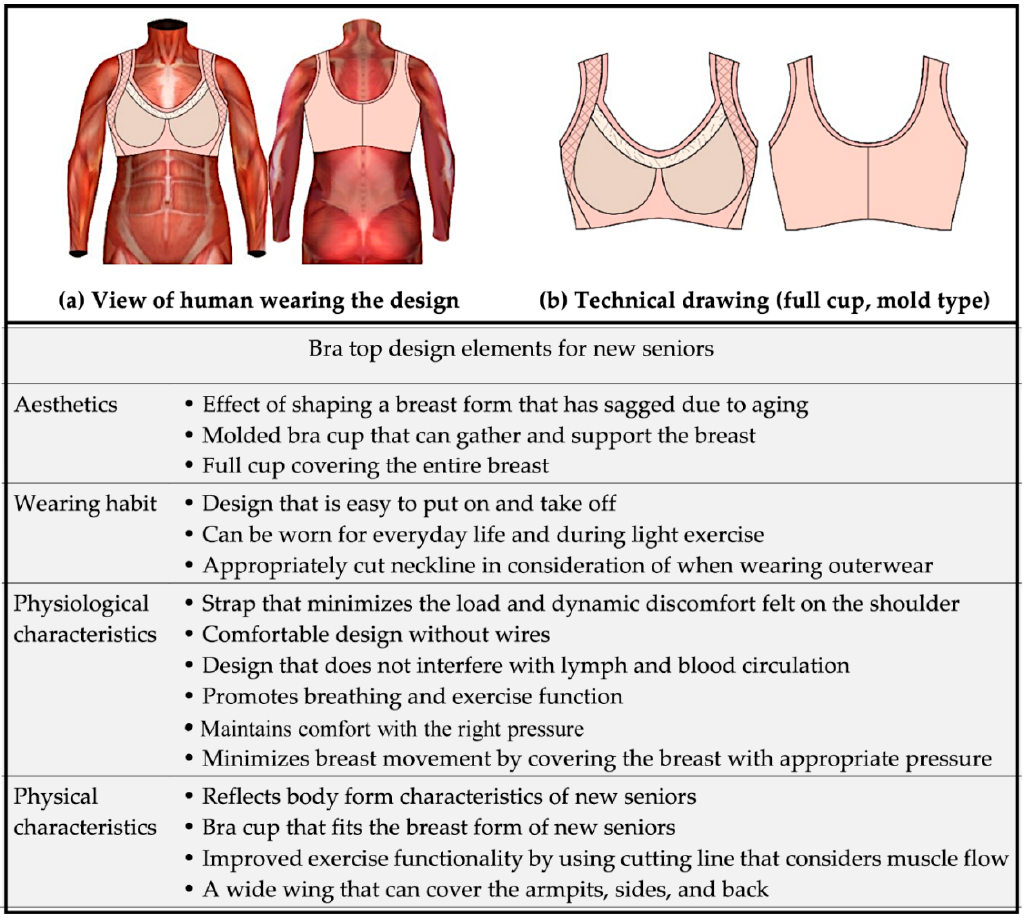
Figure 3. Results for a bra top design that reflects the needs of consumers.